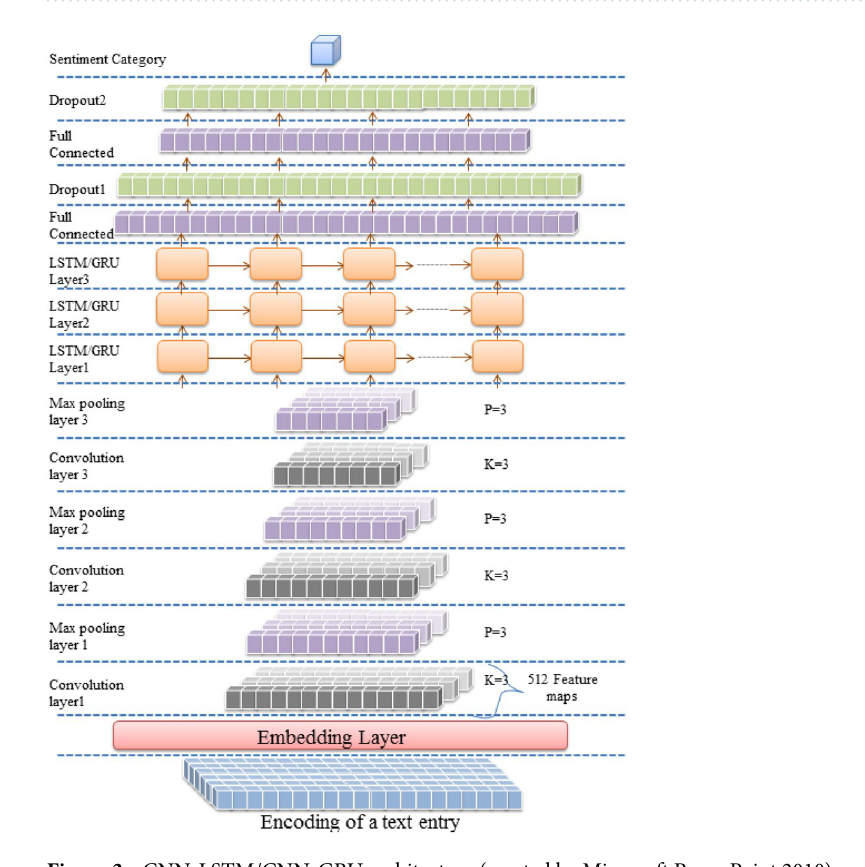
Figure 3. CNN-LSTM/CNN-GRU architecture (created by Microsoft PowerPoint